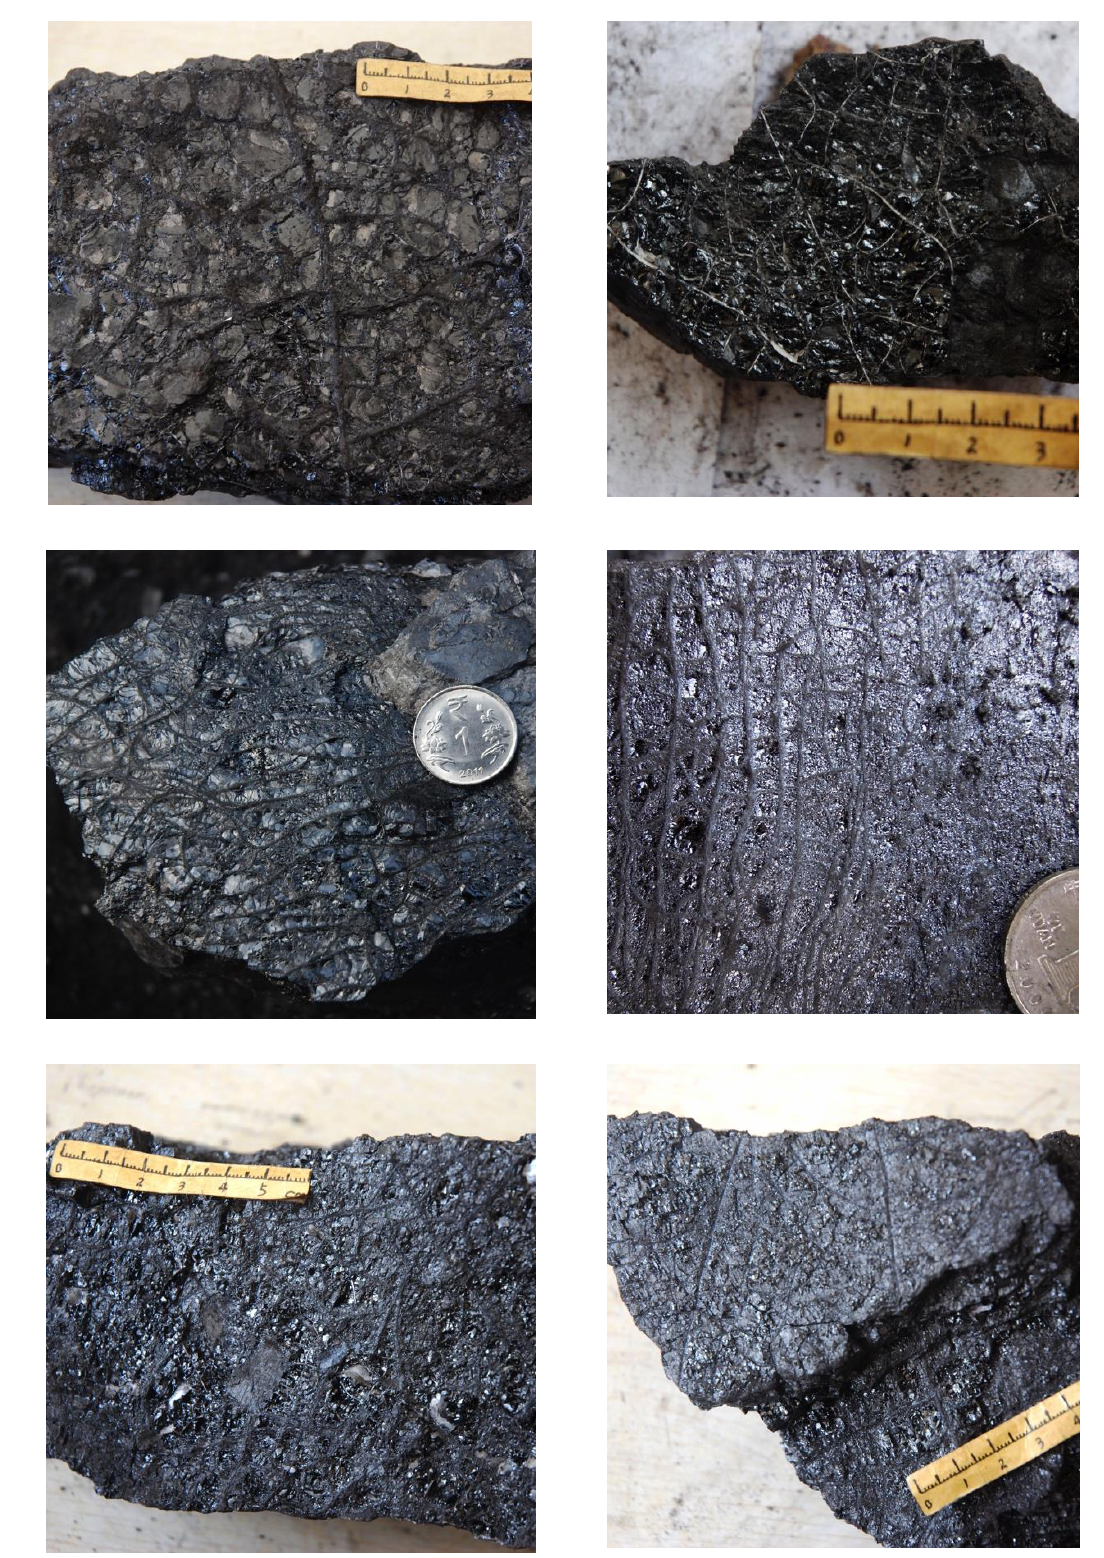
Figure 2. Photographs of the bedding surfaces of cleated structural coals, from Western Guizhou and eastern Yunnan, Southwestern China.